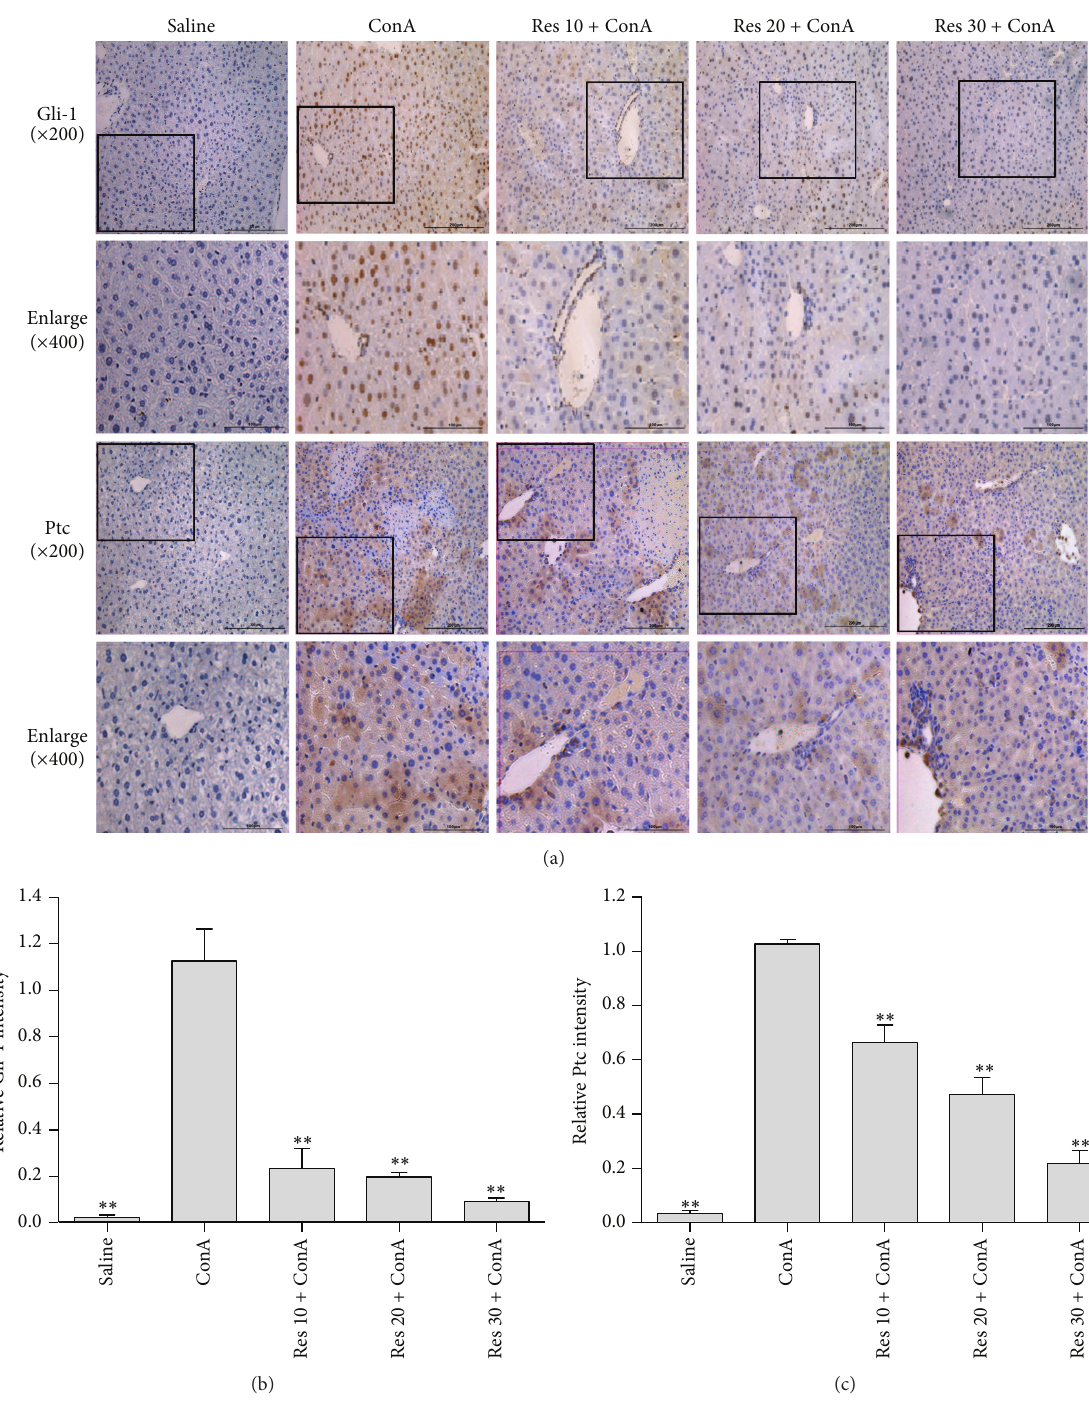
Figure 3: Immunohistochemistry used to detect the expression level of Gli-1 and Ptc 8 hours in all five groups (saline group, ConA model group; ConA + 10mg/kg Res; ConA + 20 mg/kg Res; ConA + 30 mg/kg Res). Gli-1 and Ptc showed a strong immunoreactivity in ConA sections, but it was weak after Res application in different dose